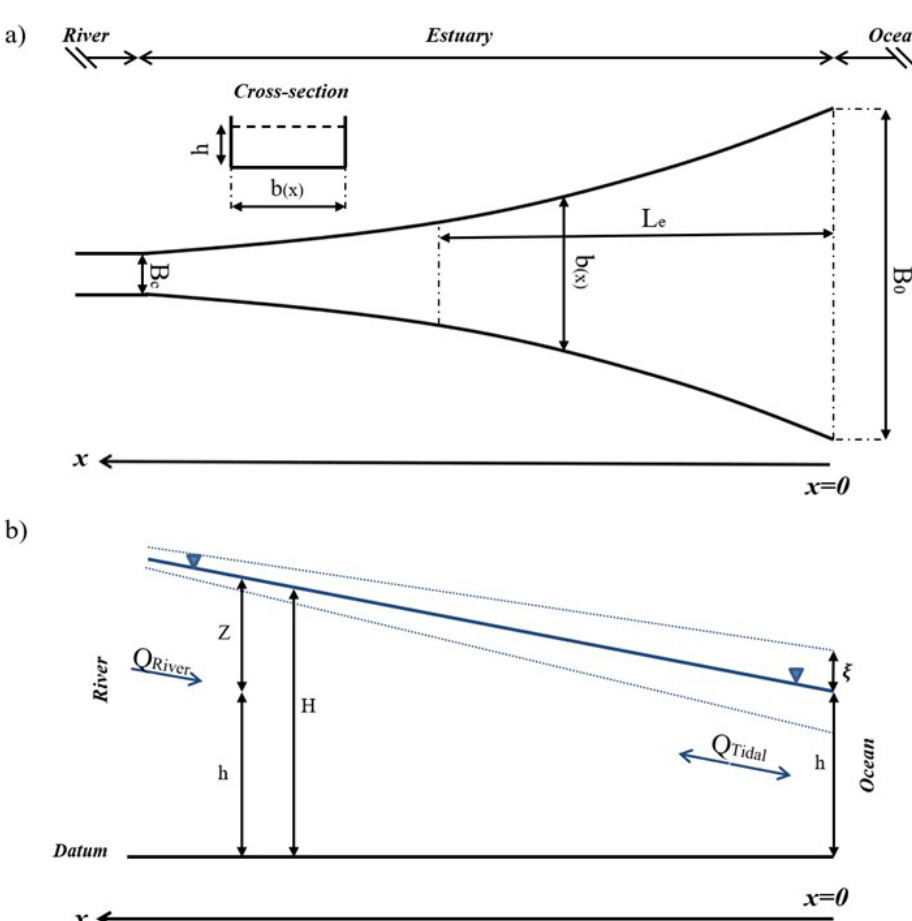
Figure 1. (a) Idealized bathymetry and plan view of the conceptual model and (b) definition of the water surface slope, modified from Kukulka and Jay (2003b). The along-channel direction x is upstream, with x = 0 being at the ocean. The convergent section of the model domain is 1.5 times the convergence length, and the river channel at the left-hand side extends an additional 100km to enable tidal and surge constituents to damp out. See Appendix A for a description of